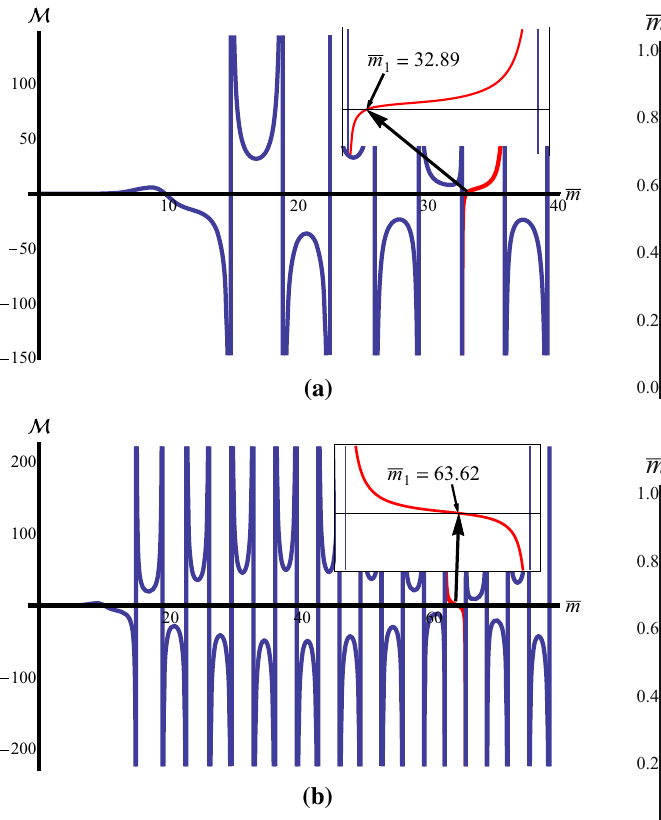
Fig. 10 The effect of the size of the extra dimension ¯ z b (small ¯ z b < 1) on the mass spectrum of the left-chiral fermion KK modes. The other parameters are set to k = − 3 and η = 40 − J ( m n )/ Y ( m n ) and 1 1 β β